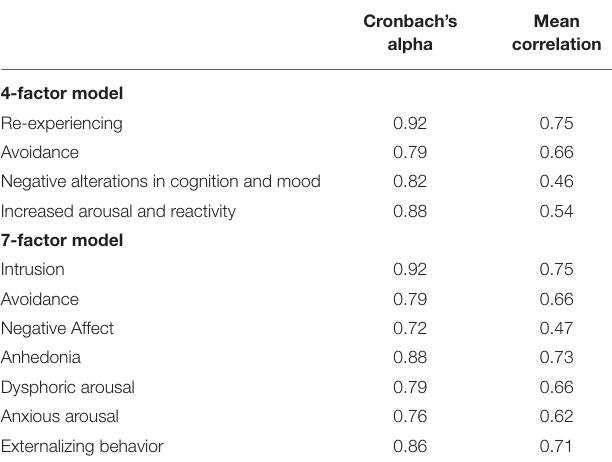
TABLE 4 | Reliability analysis of the